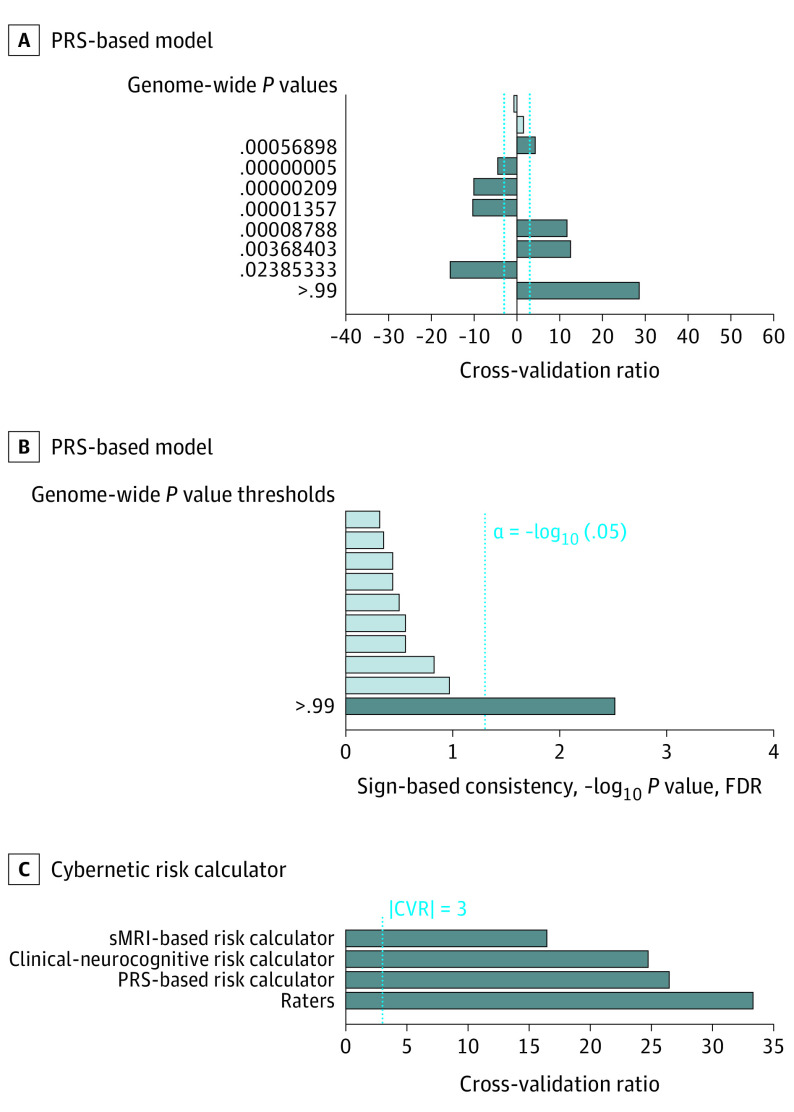
Predictive Signatures Underlying the Polygenic Risk Score (PRS)–Based and Cybernetic Risk Calculator ModelsThe reliability of predictive pattern elements was evaluated using cross-validation ratio (CVR) mapping (A). In addition, the significance of predictive features used by the PRS-based model was assessed by means of sign-based consistency mapping (B) (as described in the eMethods in the Supplement). The cybernetic model combines all algorithmic and human components (C). FDR indicates false discovery rate; and sMRI, structural magnetic resonance imaging.